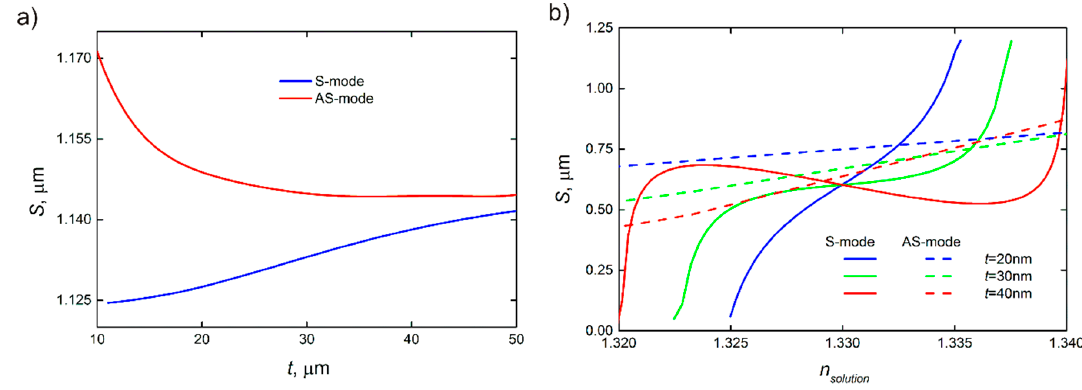
Figure 5. Dependence of sensitivity on essential parameters. The sensitivity of plasmonic biosensor depending ( a ) on the thickness of waveguide and type of mode, and ( b ) on RI of the test solution with different thicknesses. The RI of the dielectric substrate in this scheme is 1.33. The difference between RI of media on both sides of the waveguide has a significant effect on sensitivity. Table 1. Comparison of the sensitivity and detection limit (DL) for different types of biosensors. RIU—refractive index unit.